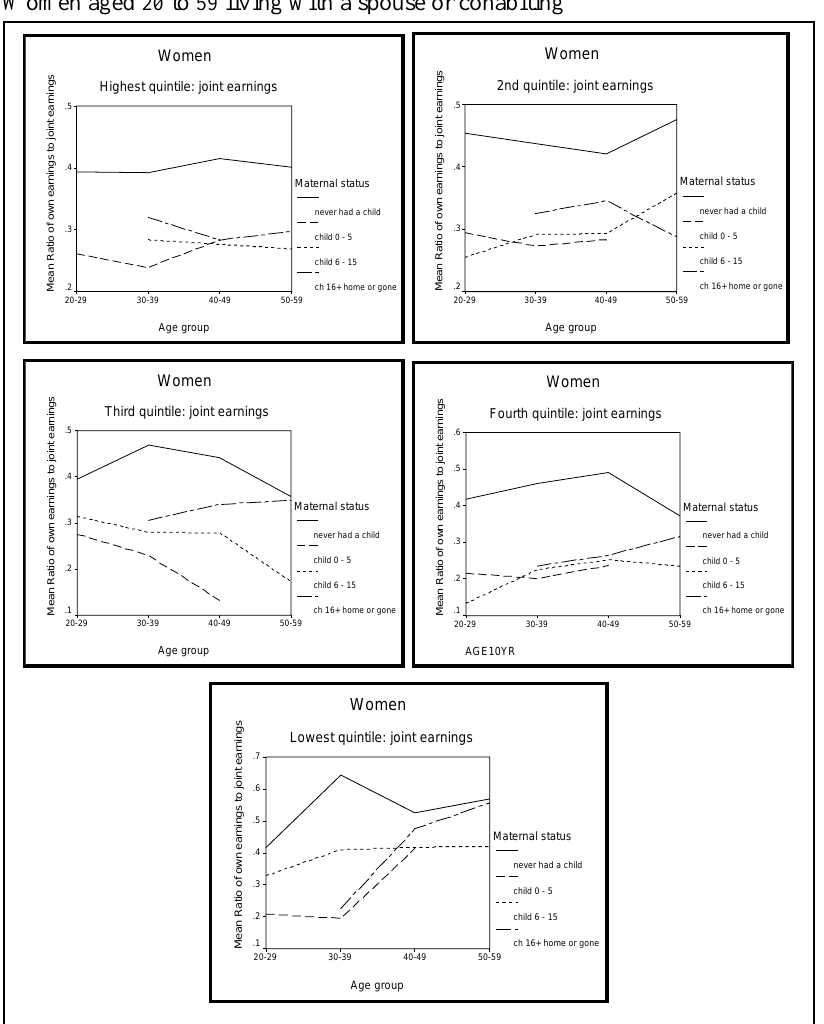
Figure 6. The impact of motherhood on earnings’ equality within couples. Women aged 20 to 59 living with a spouse or